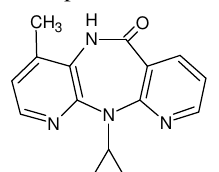
Figure 1. Structure of